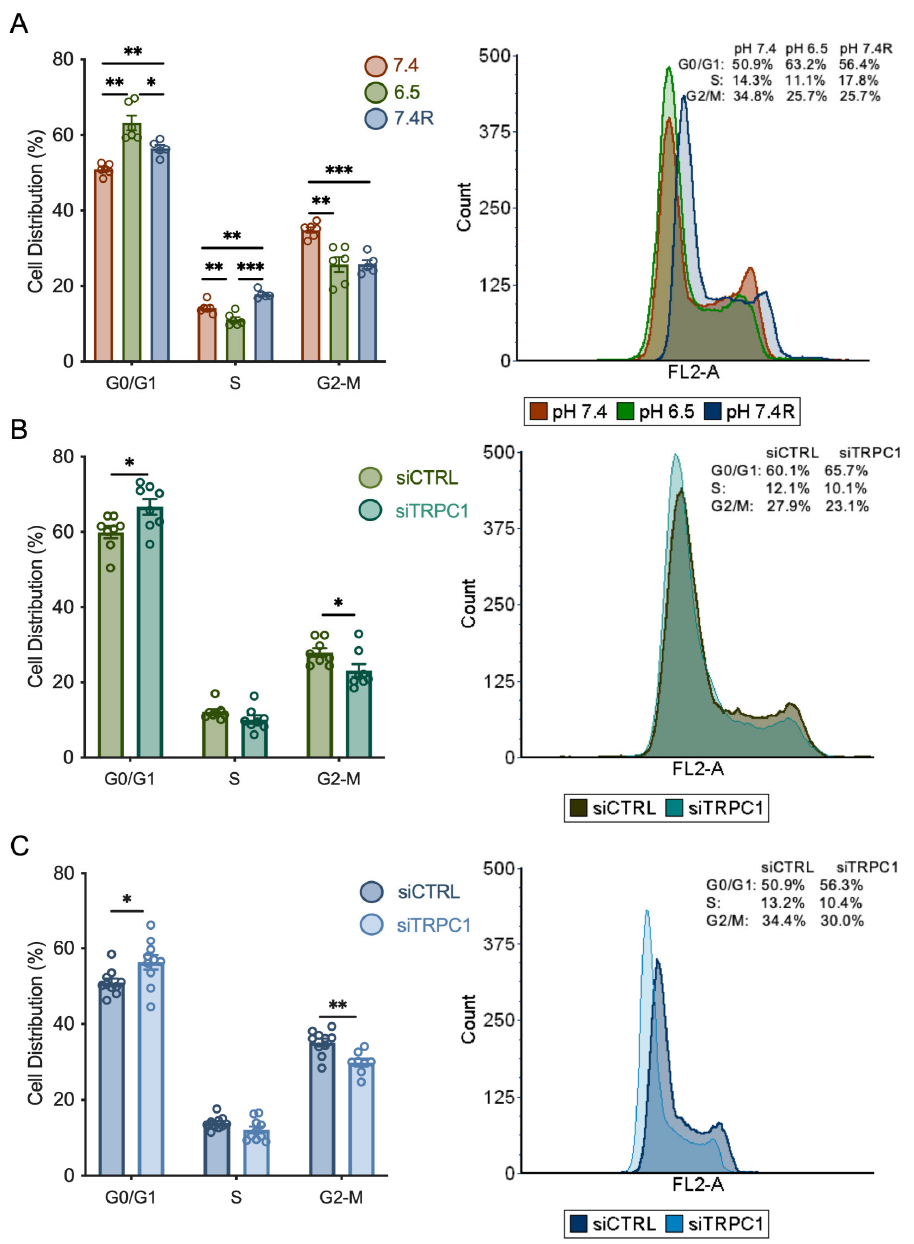
Figure 4. TRPC1 silencing accumulates cells in the G0/G1 phase and reduces the number of cells in the G2/M phase in both acid adaptation and recovery conditions. ( A ) Quantification of cell cycle analysis representing the percentage of cells in each cell cycle phase of non ‐ transfected PANC ‐ 1 cells grown under normal pH (7.4), acid adaptation (6.5) or acid recovery conditions (7.4R) (left panel) and representative data from FACS acquisition (right panel). ( B ) Quantification of cell cycle analysis representing the percentage of cells in each cell cycle phase of siTRPC1 transfected PANC ‐ 1 cells grown under acid adaptation (6.5) or ( C ) acid recovery conditions (7.4R) (left panel), and representative data from FACS acquisition (right panel). Welch’s correction t ‐ test was used to determine the significant difference between different conditions. *, **, and *** indicate p < 0.05, 0.01, and 0.001, respectively.